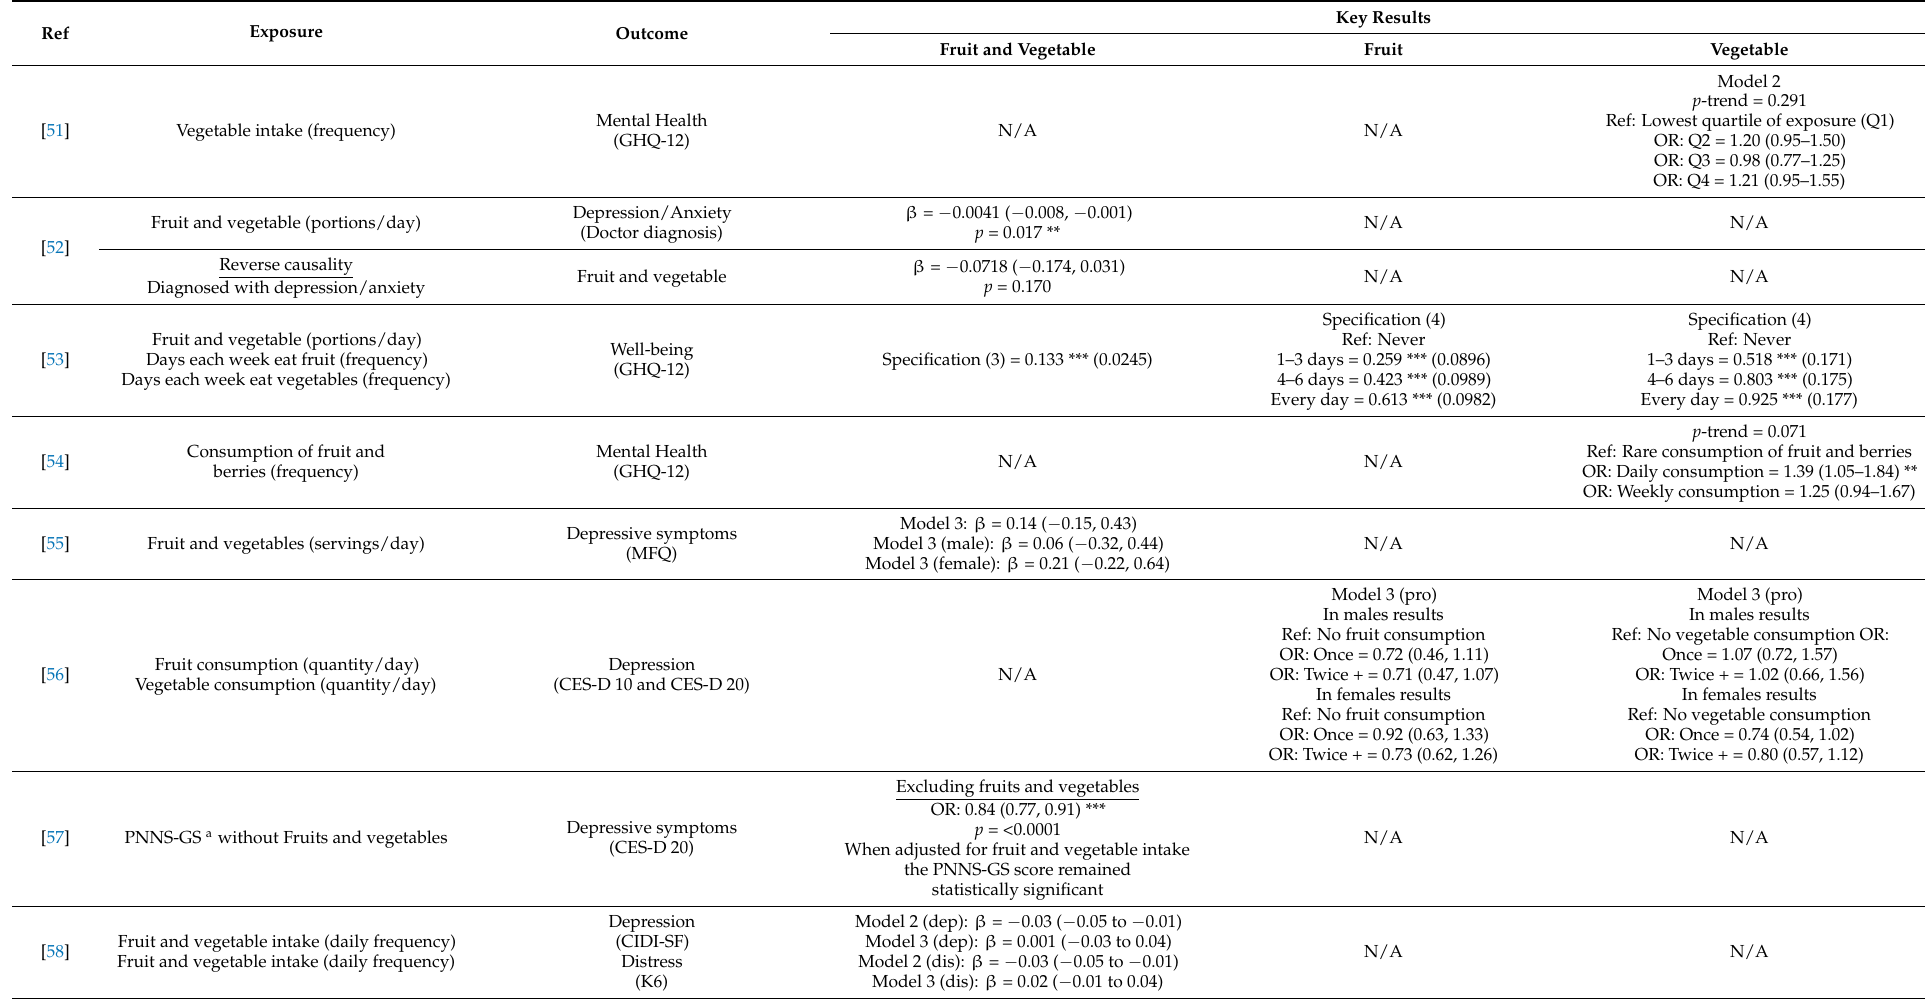
Table 2. Description of exposure, outcome and key results of